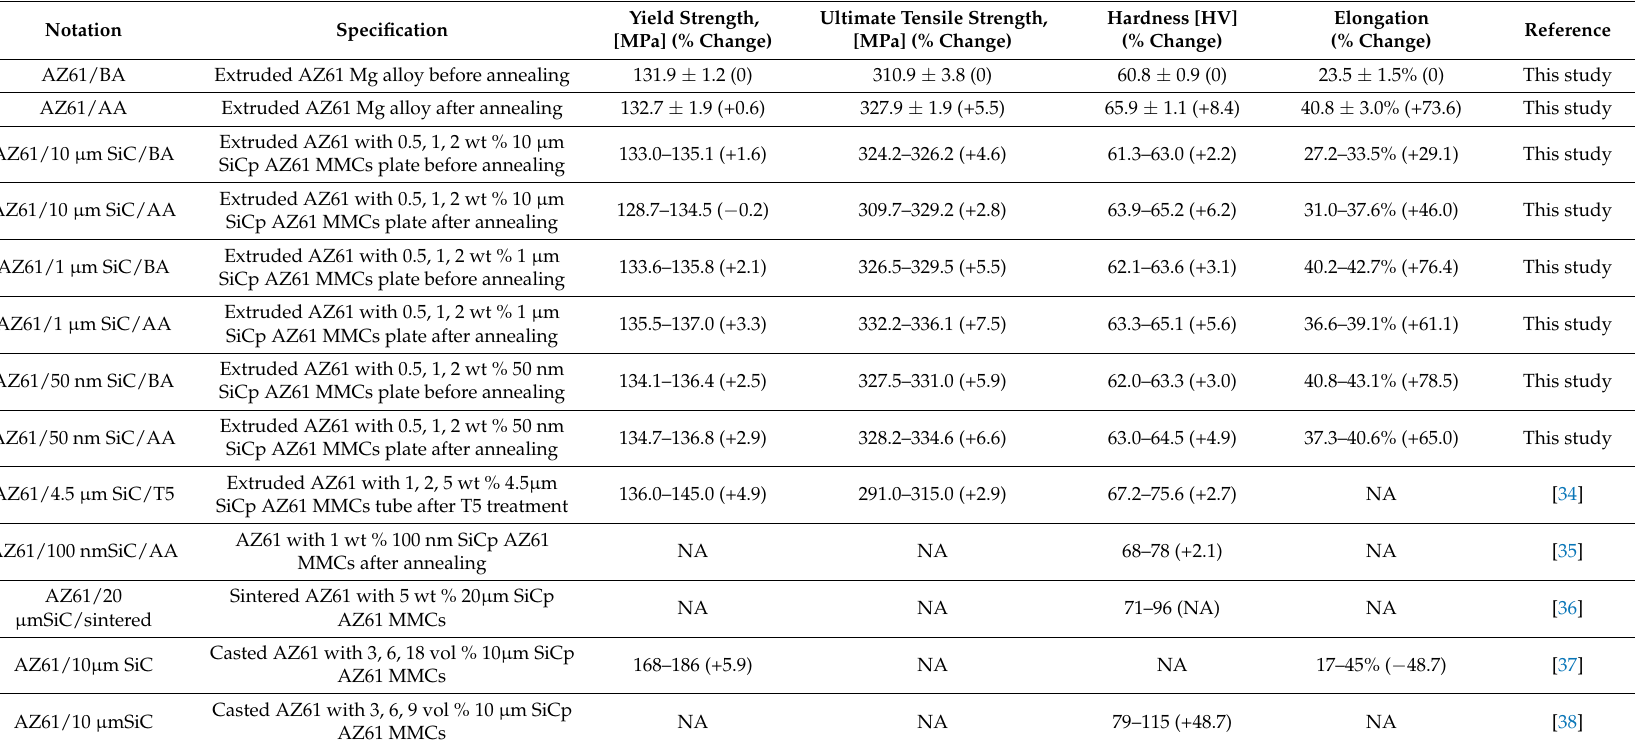
( ) Brackets indicate % change with respect to the corresponding monolithic alloy and NA means no results